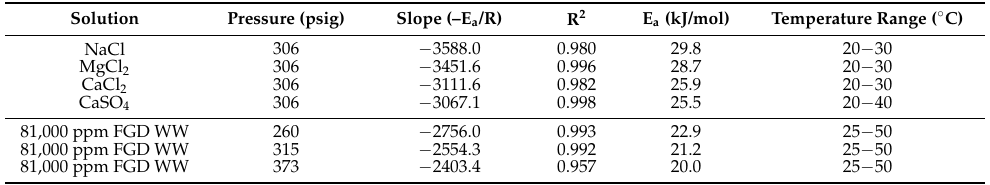
Table 3. Apparent Activation Energy for Water